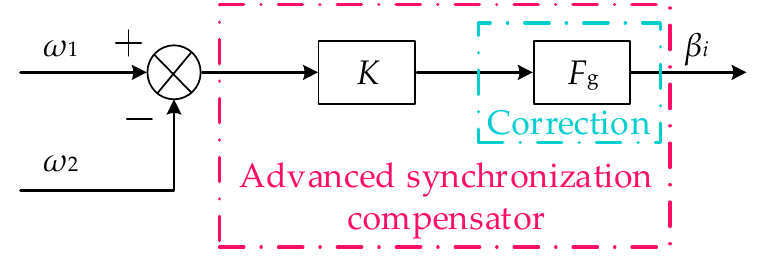
Figure 9. Advanced synchronous compensator.